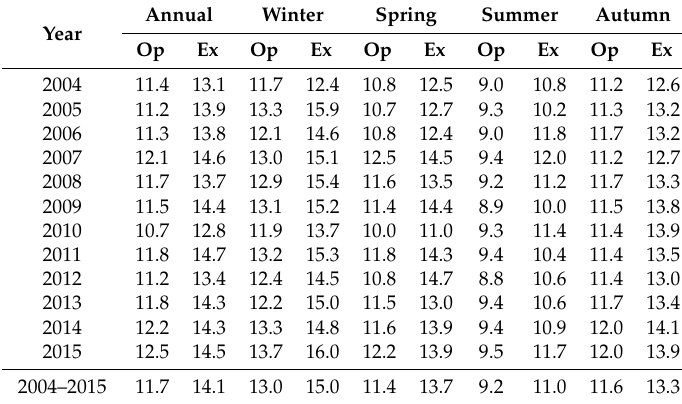
Table A8. Annual and seasonal Op and Ext T E thresholds (s) at